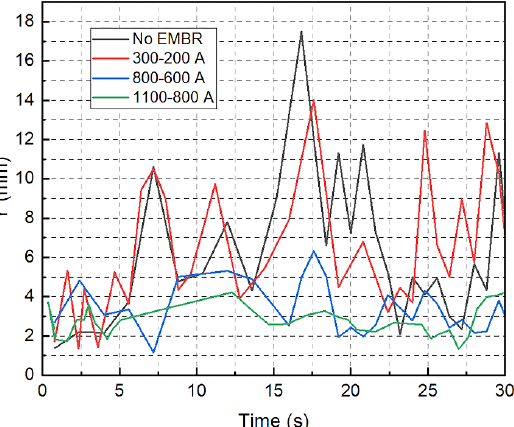
Figure 15. The maximum value (absolute value) of liquid-level wave height at different times.